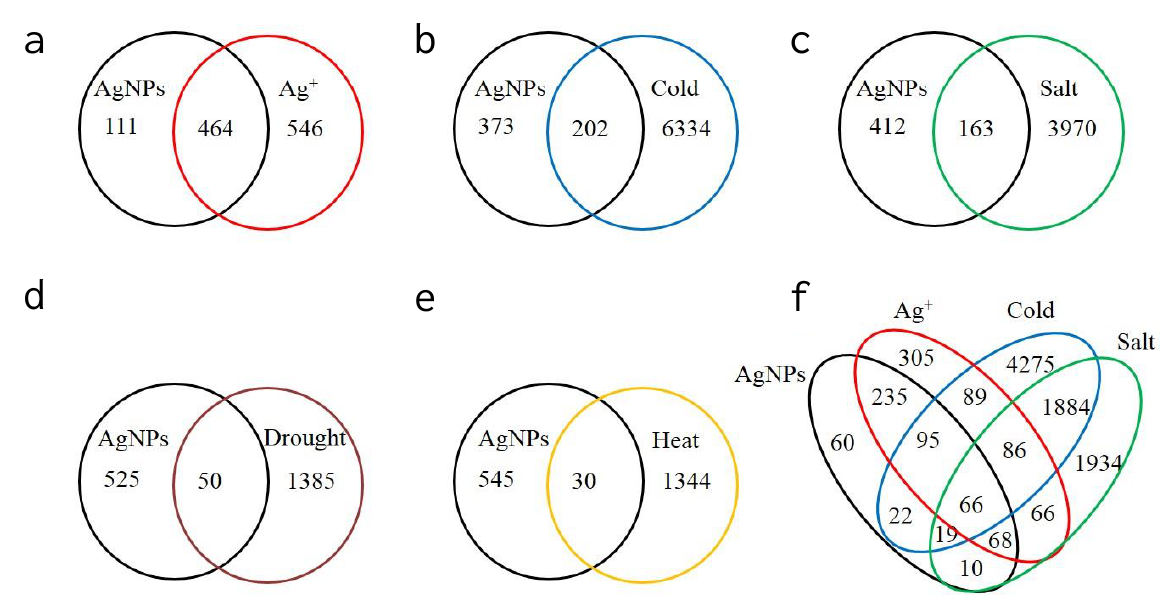
Figure 3. Venn diagrams of the genes with more than two fold expression changes and shared among the six stresses. ( a – e ) were two way comparison and ( f ) was four way. Overlapped areas were shared genes while non-overlapped areas were specific/unique genes for individual stress. ( a ) Between AgNPs and Ag + ; ( b ) Between AgNPs and cold; ( c ) Between AgNPs and salt; ( d ) Between AgNPs and drought; ( e ) Between AgNPs and heat; ( f ) Among AgNPs, Ag + , cold and